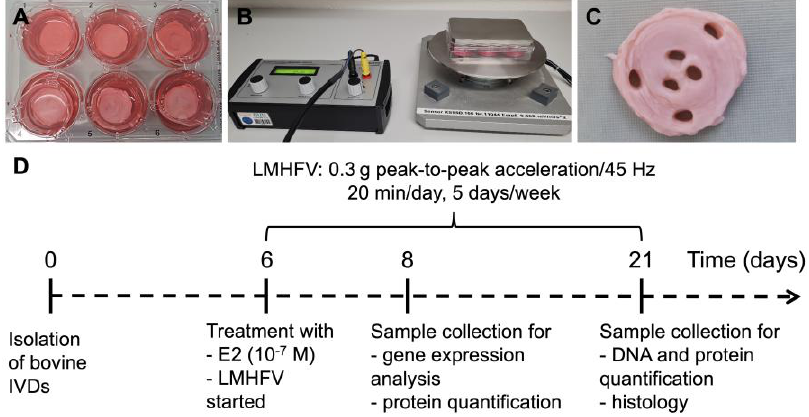
Figure 1. Bovine tail intervertebral disc organ culture experiments from day 0 until day 21. Treatment of the discs with 17β-oestradiol (E2, 100 nM), low-magnitude high-frequency vibration (LMHFV, 0.3 g peak-to-peak acceleration/45 Hz 20 min/day, 5 days/week) or both in combination (E2 + LMHFV) was initiated at day 6. ( A ) Isolated discs. ( B ) Custom-made vibration platform with discs under vibration. ( C ) Disc after removal of annulus fibrosus and nucleus pulposus tissue sam- ples for further evaluations. ( D ) Timeline of the experiments.